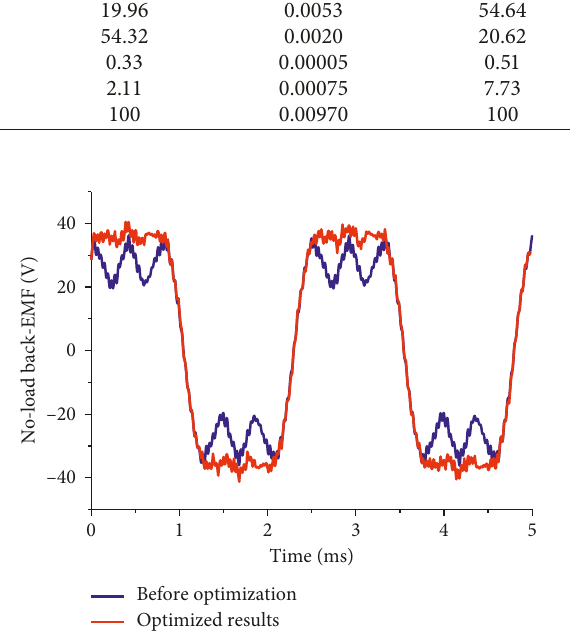
Figure 7: Comparison results of back-EMF